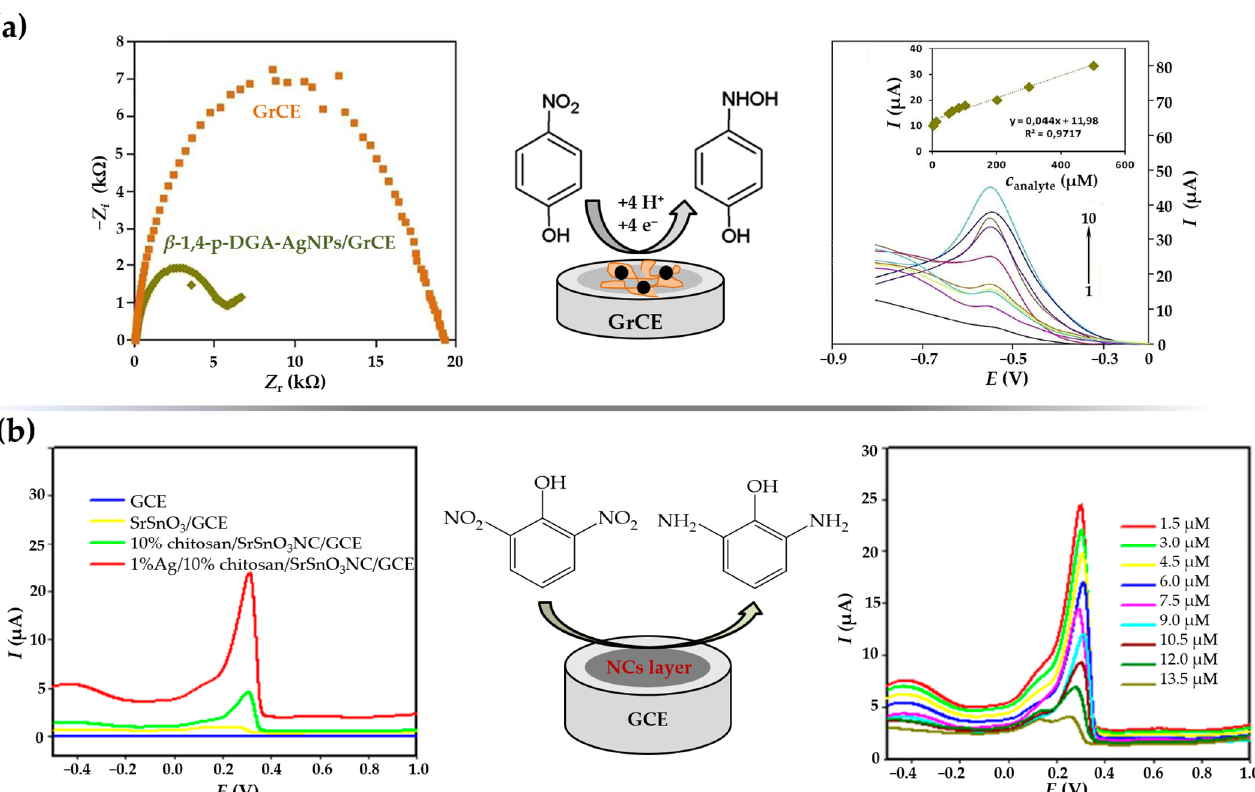
Figure 8. Schematic illustration of the selected voltammetric sensors for the detection of phenolic compounds in water matrices. ( a ) Voltammetric platform based on β -1,4- p -D-glucosamine-capped AgNPs modified graphite carbon electrode for the detection of 4-NP in wastewater and river water: Nyquist plots for bare and modified GrCE, the mechanism of reduction, and corresponding DPV responses. Reproduced with permission from Ref. [156]; copyright 2023 John Wiley and Sons. ( b ) Ag-chitosan/SrSnO 3 NC/GCE sensor for the voltammetric detection of 2,6-DNP in seawater, underground water, and tap water. Adapted from [161] under the terms of the Creative Commons Attribution (CC BY) licence (https://creativecommons.org/licenses/by/4.0, accessed on 26 February 2023.). Table 3. Survey of the reviewed silver nanomaterial-based electrochemical sensors for detection of phenolic compounds in water matrices.